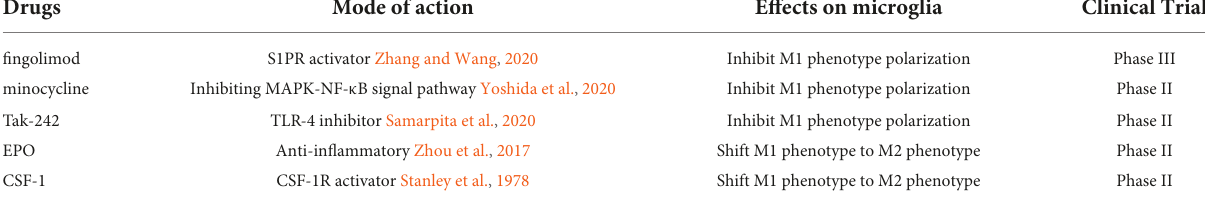
TABLE 2 Anti-TBI